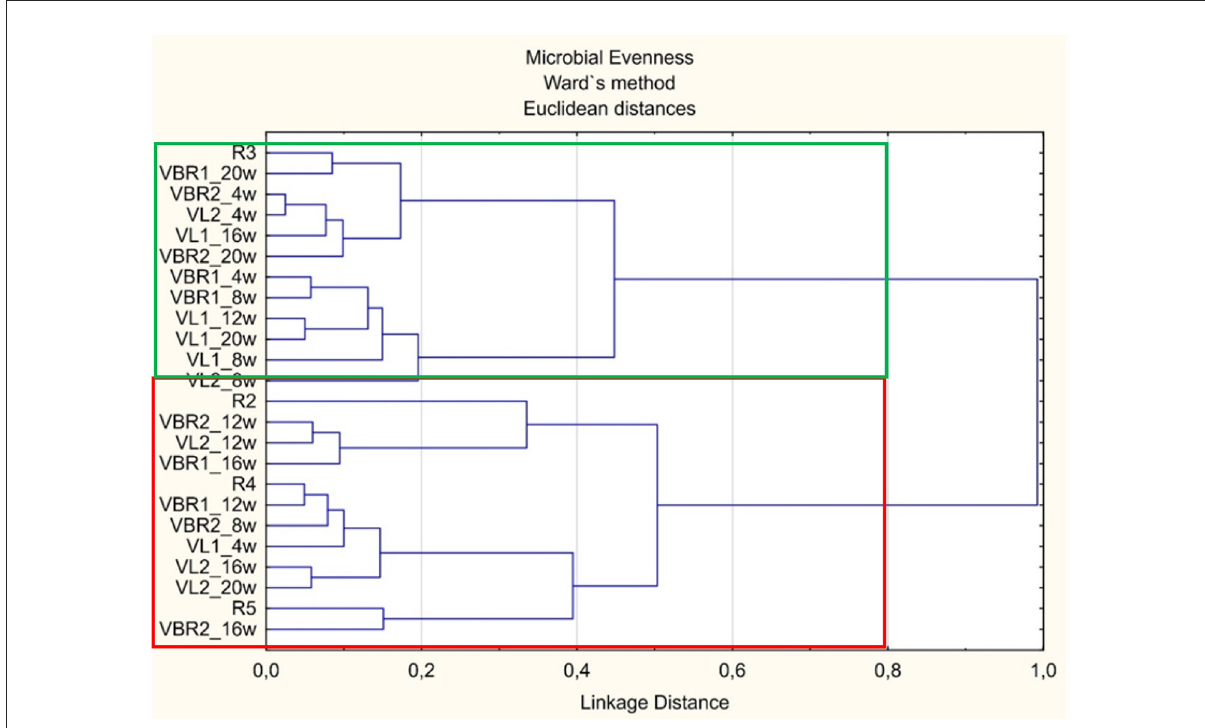
FIGURE2 Dendrogram illustrating the differences in microbial evenness between landraces and growth stages soil samples over